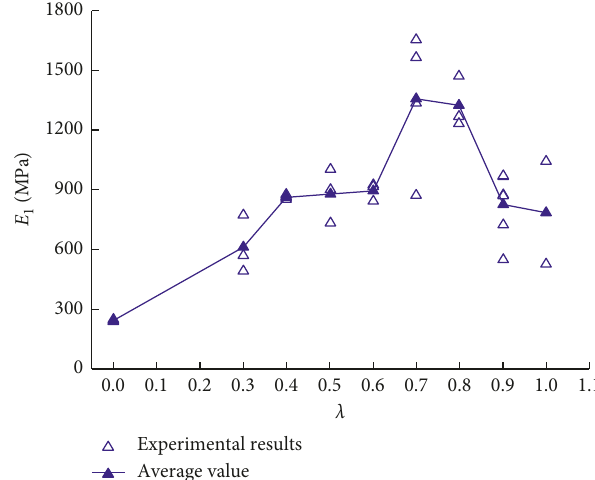
Figure 9: Variation in first-stage deformation modulus of artificial frozen silty clay with axial precompressive stress ratio.